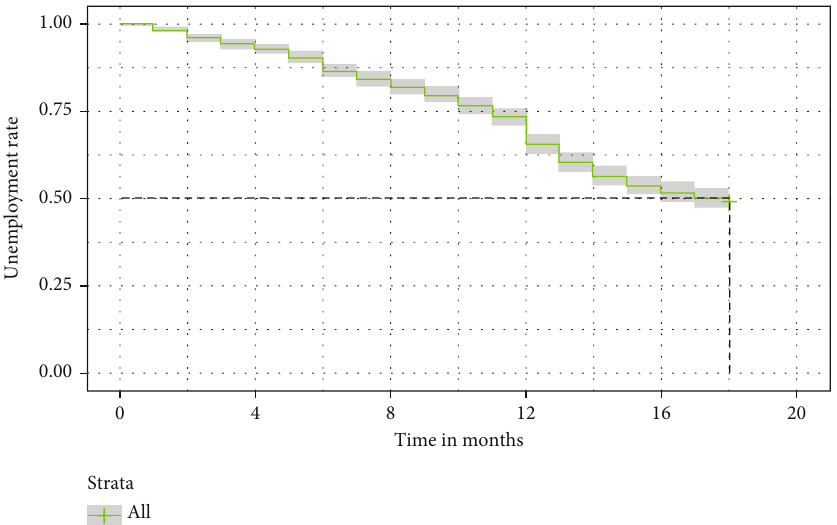
Figure 1: Unemployment time of